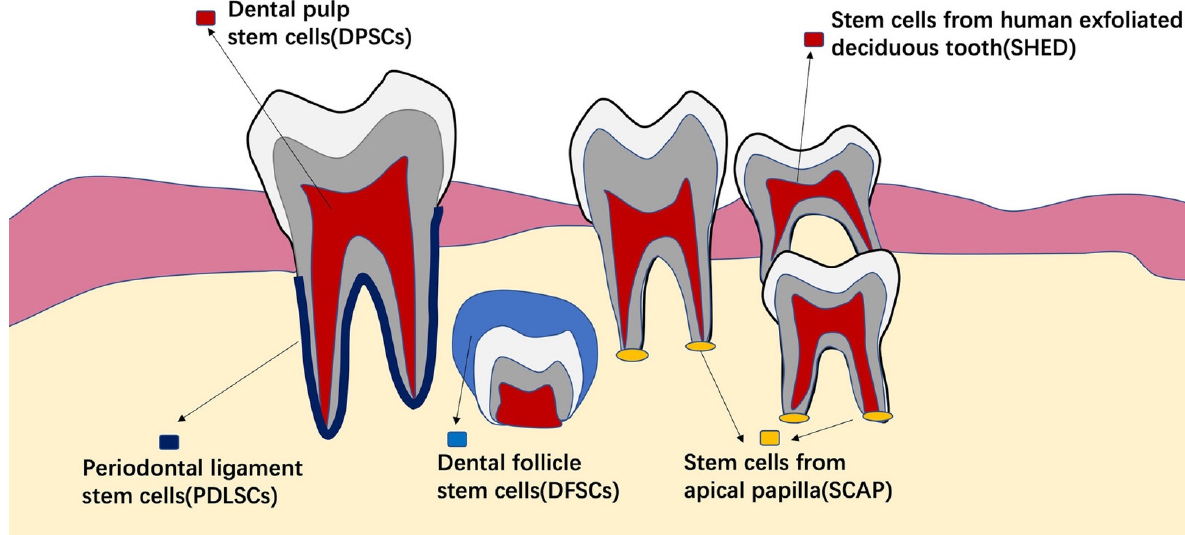
Figure 5. DSCs, which include DPSCs, PDLSCs, DFSCs, SHEDs, and SCAPs, are classified into numerous groups depending on their origin. The dental pulp is used to isolate DPSCs. PDLSCs are a type of cell found in the PDL. SHEDs are formed when deciduous teeth are exfoliated. DFSCs are obtained from the dental follicle of a tooth that has not yet erupted. The apical papilla is used to isolate SCAPs. The figure was adapted from Wang et al. (2019) [181] .